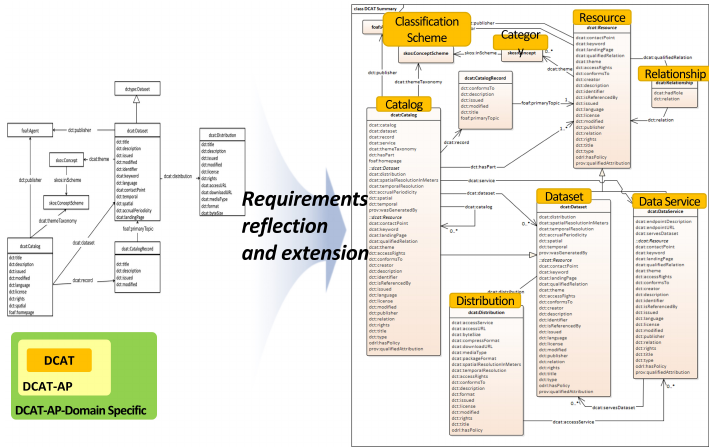
Figure 2. Structure comparison of DCATv1 and